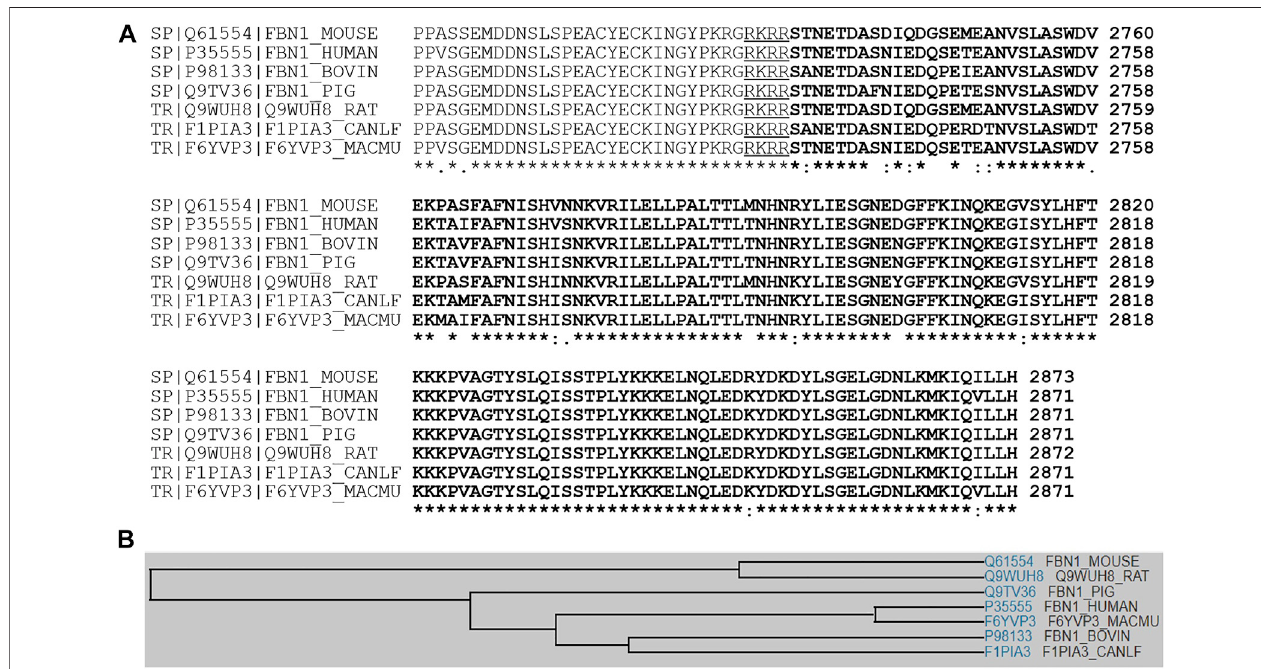
FIGURE 1 | (A) Multiple sequence alignment analyses signifying amino acid sequence identity and similarity among asprosin in various species of human, mouse, rat, pig, dog, bovine, and rhesus macaque. (B) A family tree of asprosin proteins is presented.